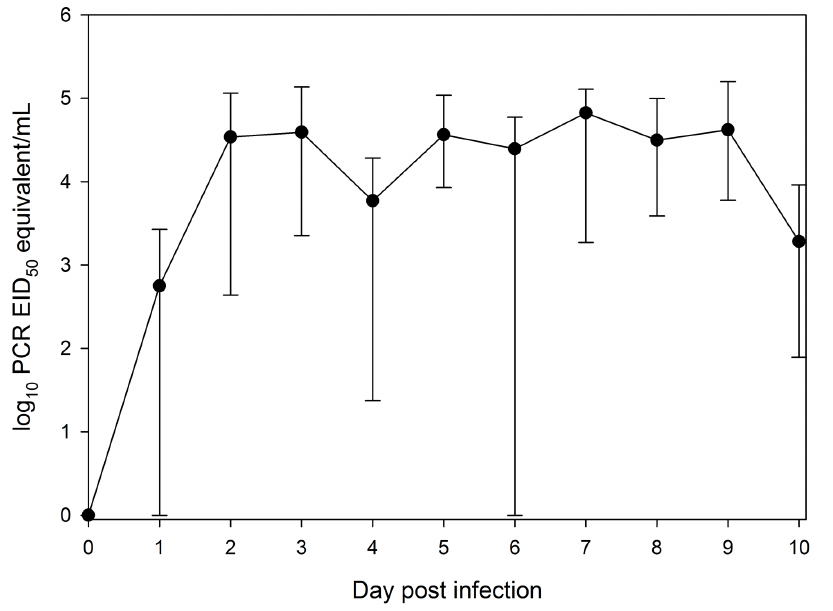
Figure 2. Mean oral shedding of avian influenza virus RNA of striped skunks ( Mephitismephitis ) experimentally infected with a low- pathogenic avian influenza virus. Shedding was assessed from oral swabs by RRT-PCR. Results are presented as log 10 PCR EID 50 equivalents/mL. Vertical bars represent the maximum and minimum quantities detected on a given day.